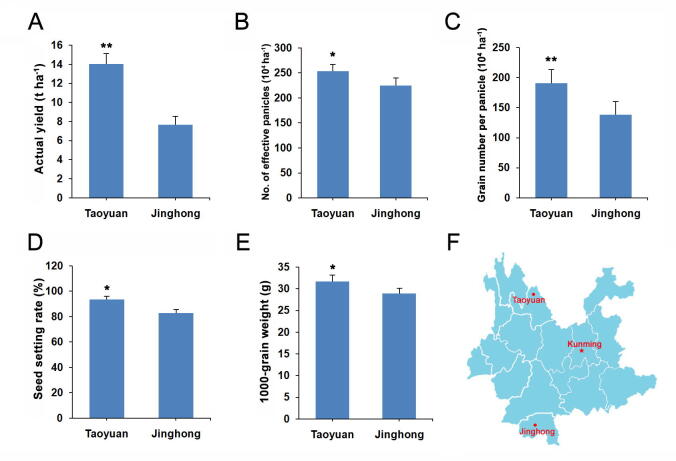
Four years' average yield and yield components of the variety 9311 at Taoyuan and Jinghong. A. Actual yield. B. Effective panicle numbers. C. Grain number per panicle. D. Seed setting rate. E. 1000-grain weight. *, P < 0.05; **, P < 0.01. F. Location of Taoyuan and Jinghong in Yunnan, China.